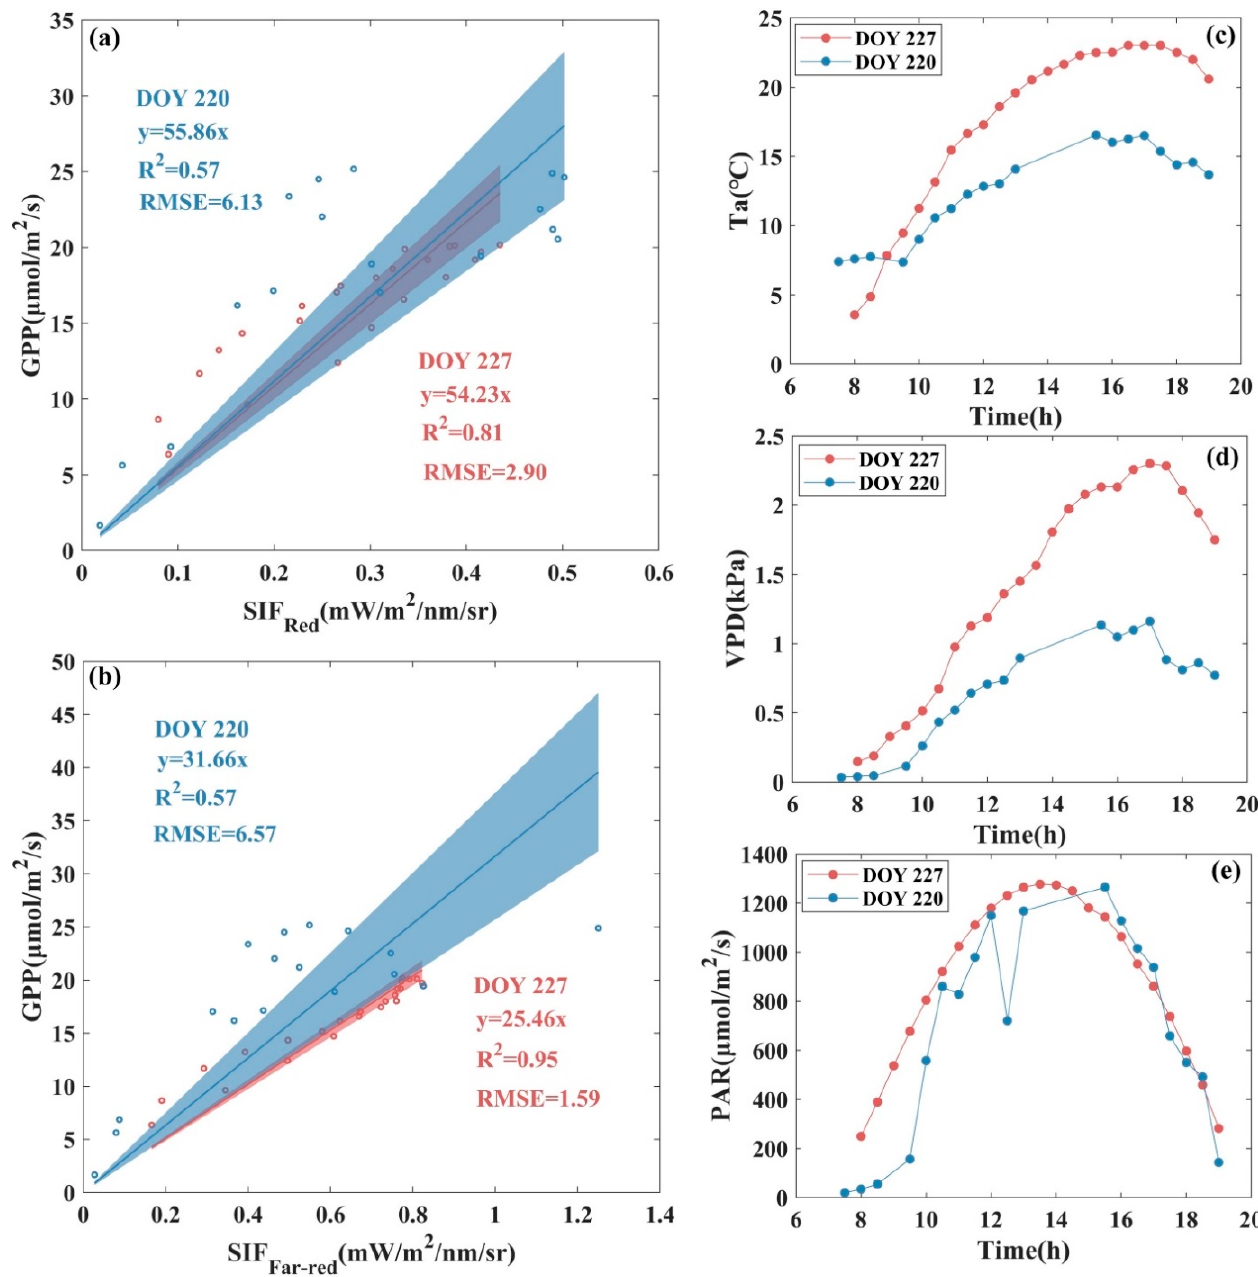
Figure 5. Scatter plot of the fitted relationship between ( a ) SIF Red , ( b ) SIF Far-red , and GPP at the diurnal scale and daily variations of ( c ) air temperature (Ta), ( d ) vapor pressure deficit (VPD), and ( e ) photosynthetically active radiation (PAR) for DOY220 and DOY227 in 2020 at AR site. The scatter points represent half-hourly averaged data, the solid line represents the fitted line of the SIF-GPP relationship, and the shaded area indicates the 95% confidence level of the prediction, where red represents DOY227, and blue represents DOY220.